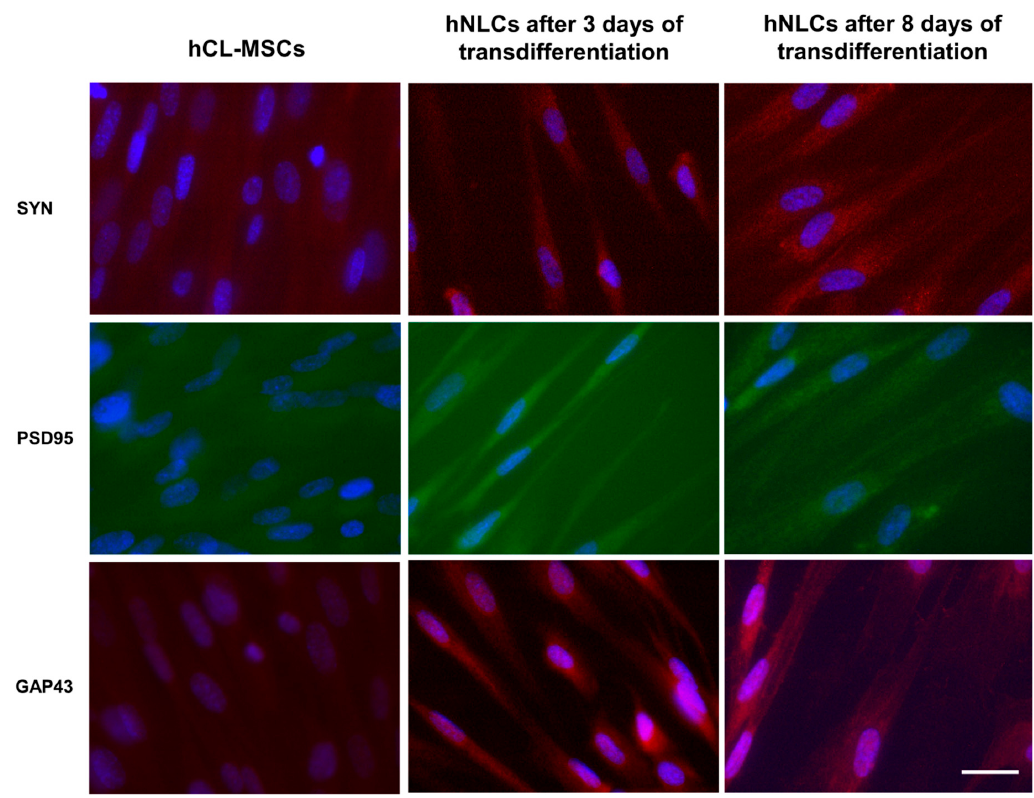
Figure 5. Immunofluorescence of synaptic markers. Representative fluorescence merged microphotographs showing SYN (red fluorescence), PSD95 (green fluorescence), and GAP43 (red fluorescence) positive in hCL-MSCs and transdifferentiated hNLCs at day 3 and 8. Nuclei were stained with Hoechst 33258. Scale bar: 100 μ m.